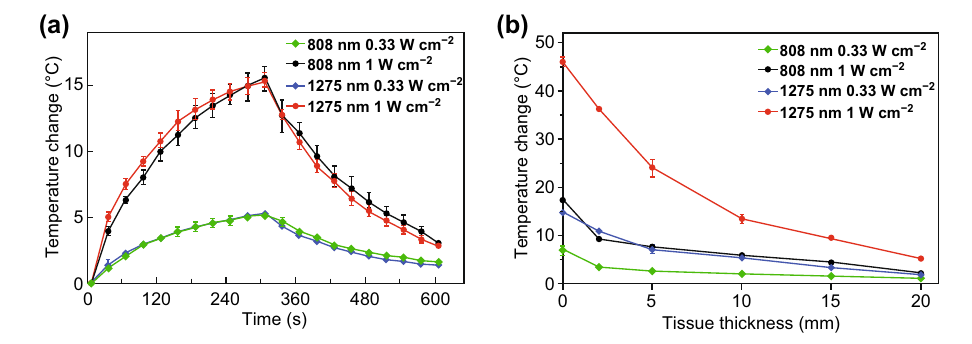
Fig. 3 Temperature rising experiments in vitro. a Heating effects of 808 and 1275 nm laser to CuS-PEG NPs without tissue blocking. b Tem- perature rise of CuS-PEG NPs solution covered with different thicknesses of porcine muscle tissues under different laser excitation conditions. The error bars represent standard deviations ( n = 3 per group)